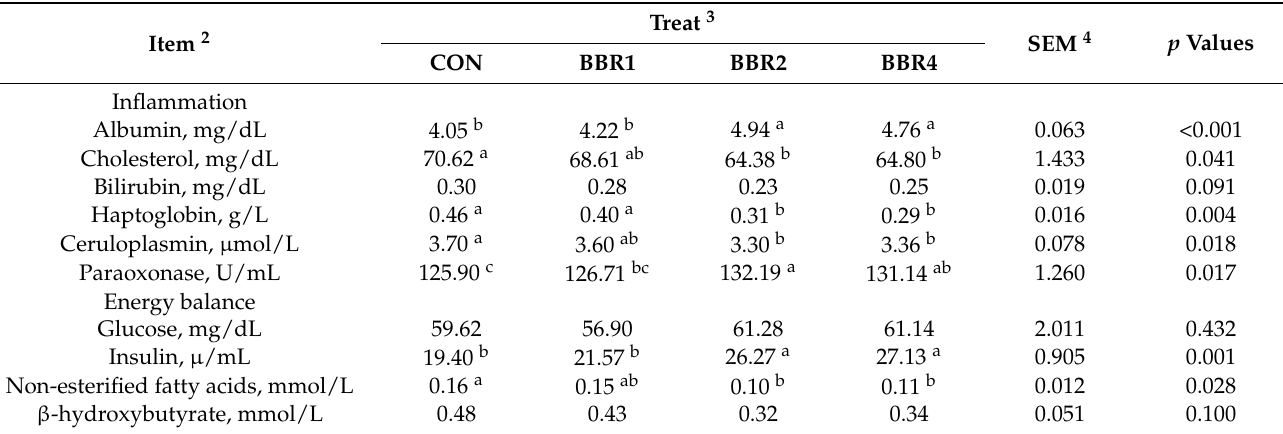
Table 3. Effect of Berberine (BBR) supplementation on biomarkers of inflammation and health status in transition dairy Saanen goats 1 .